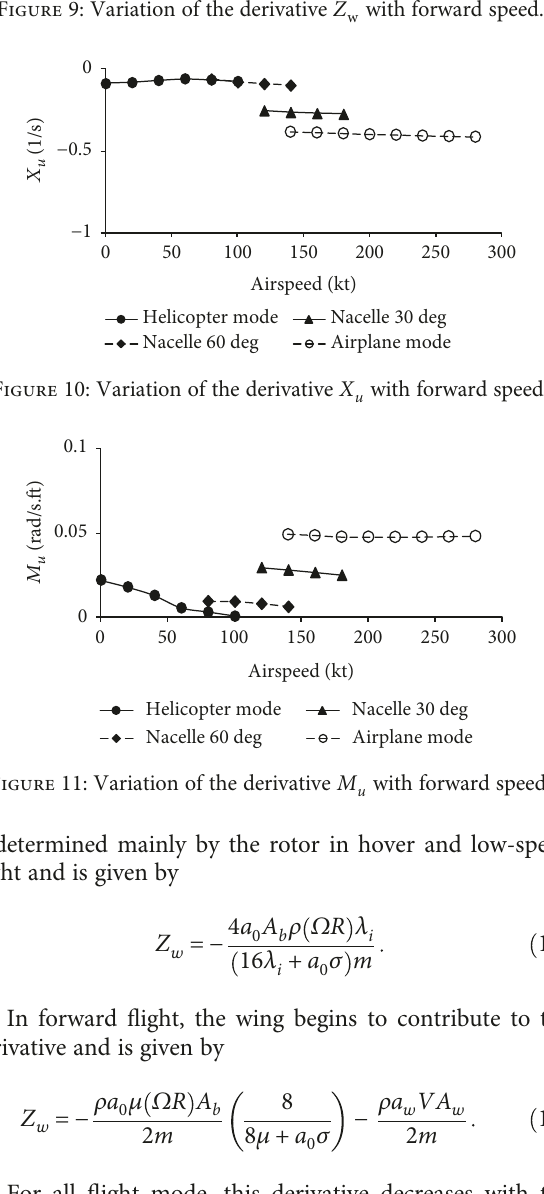
with forward speed. w